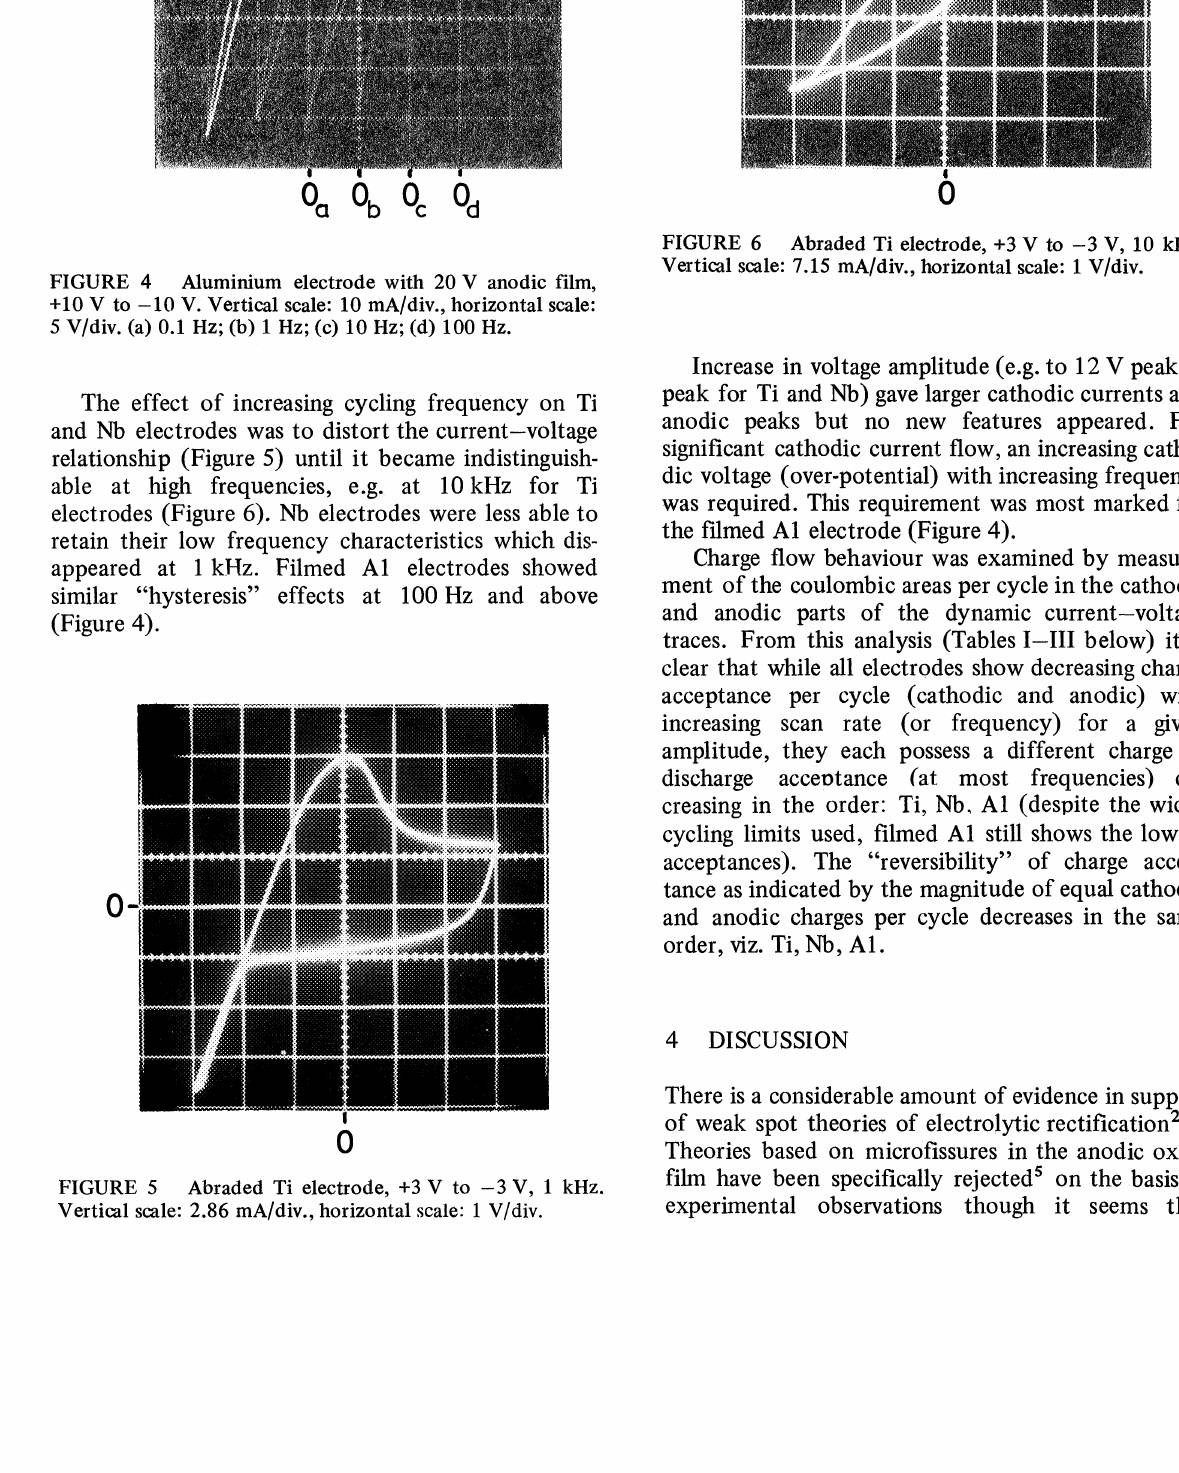
FIGURE 5 Abraded Ti electrode, +3 V to -3 V, kHz. Vertical scale: 2.86 mA/div., horizontal scale"